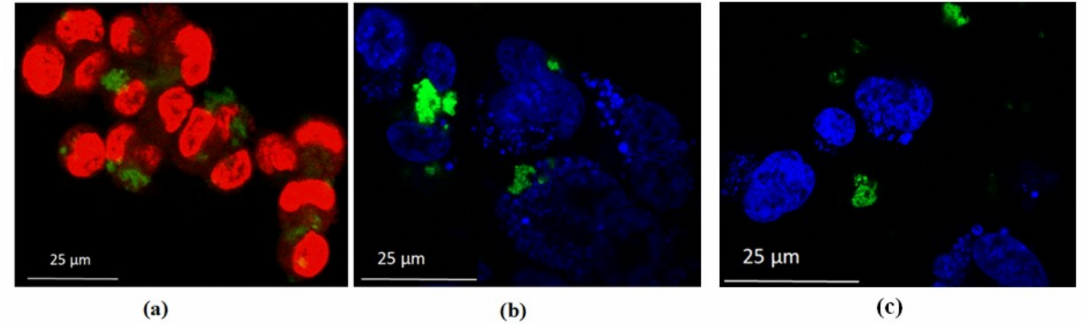
Figure 9. Confocal images of HCT-116 cells with QDs: ( a ) fixed cells (red) and CdSe(S) QDs (green); ( b ) live cells (blue) and CdSe(S) QDs (green); ( c ) live cells (blue) and CdSe(S)/ZnO QDs